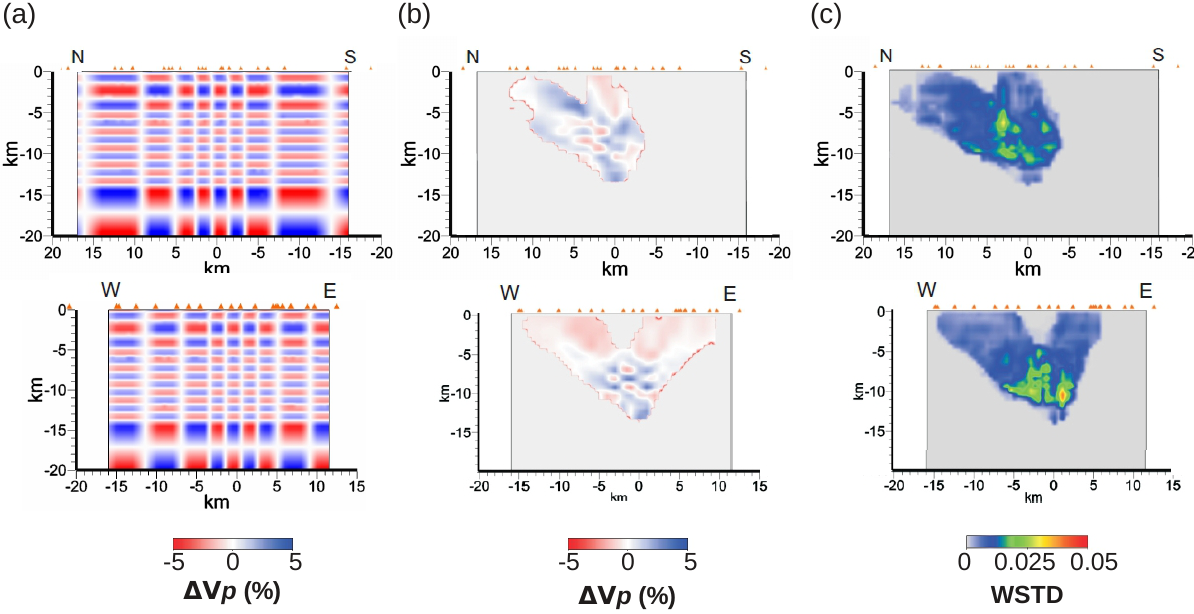
Figure 4. Checkerboard resolution test. North–south and east–west profiles (top and bottom, respectively) showing (a) the starting checker- board model with a ± 5% variation in P -wave velocity, (b) the recovered weighted average model (WAM) and (c) the weighted standard deviation (WSTD) from the observed data. Shallow areas (depth less than 5km) are not resolved. Within the focal zone, areas with poor checkerboard resolution coincide with WSTD values greater than 0.03kms − 1 . Only areas constrained by the data are shown.